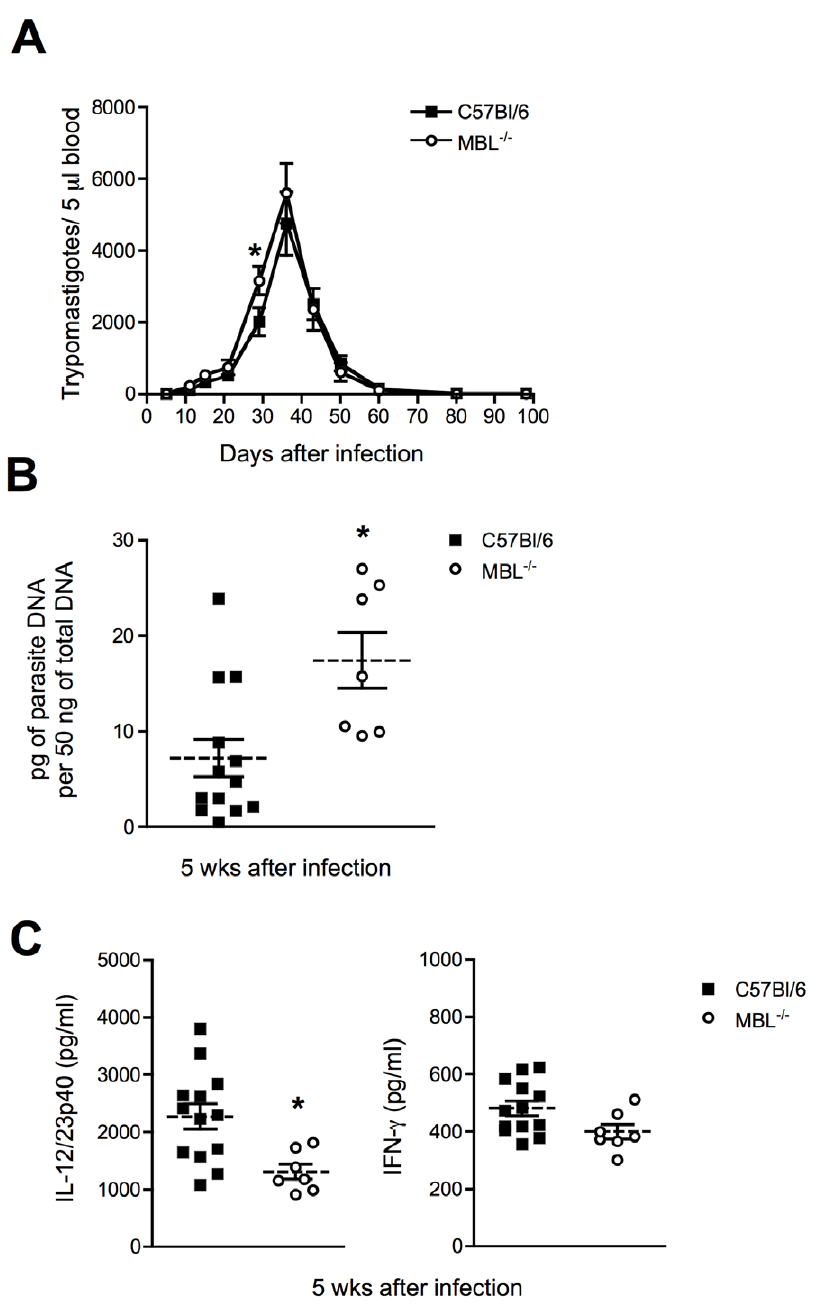
Figure 3. Role of MBL in host resistance to T.cruzi Colombiana strain infection. WT or MBL 2 / 2 mice were infected with trypomastigotes of the cardiotropic, Colombiana strain of T. cruzi and monitored weekly for parasitemia and mortality (A). Symbols represent the mean of 9 to 10 animals per group. 5 wks after infection, levels of parasite DNA in the heart were quantified by real-time PCR (B) and serum levels of IL-12/23p40 and IFN- c determined by ELISA (C). Each symbol in (B) and (C) corresponds to an individual animal, dashed lines the mean of each group and solid lines the standard error of the mean (SEM). The experiments shown are representative of two performed. *, Indicates statistically significant differences between